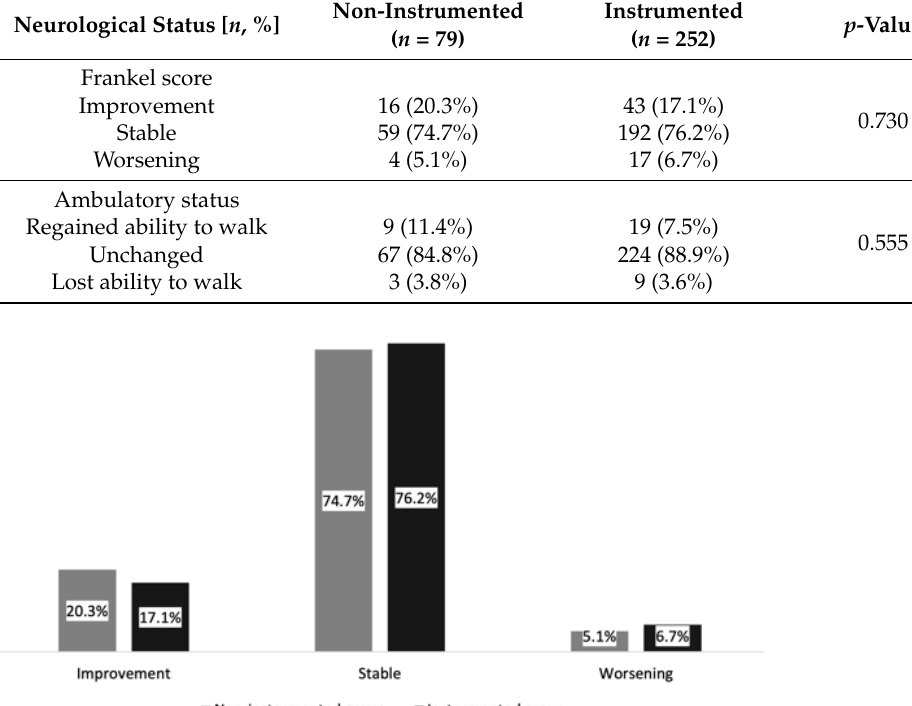
Table 3. Changes in Frankel score and ambulatory status between initial examination and last follow-up.